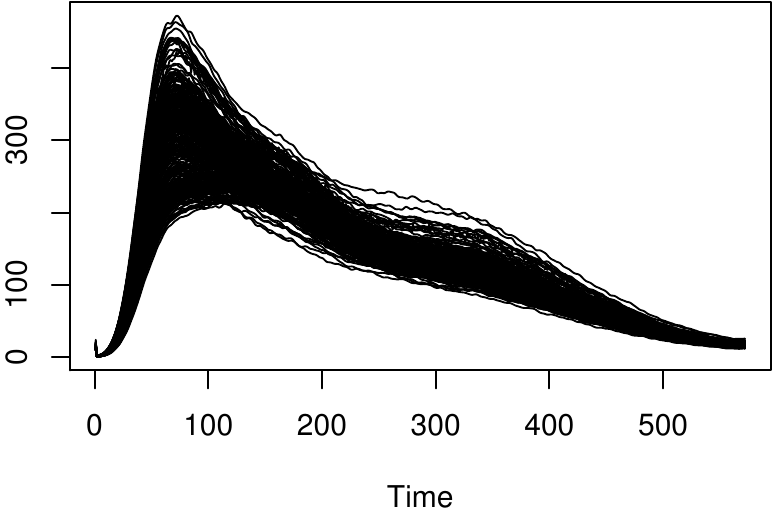
Figure 3. The functional